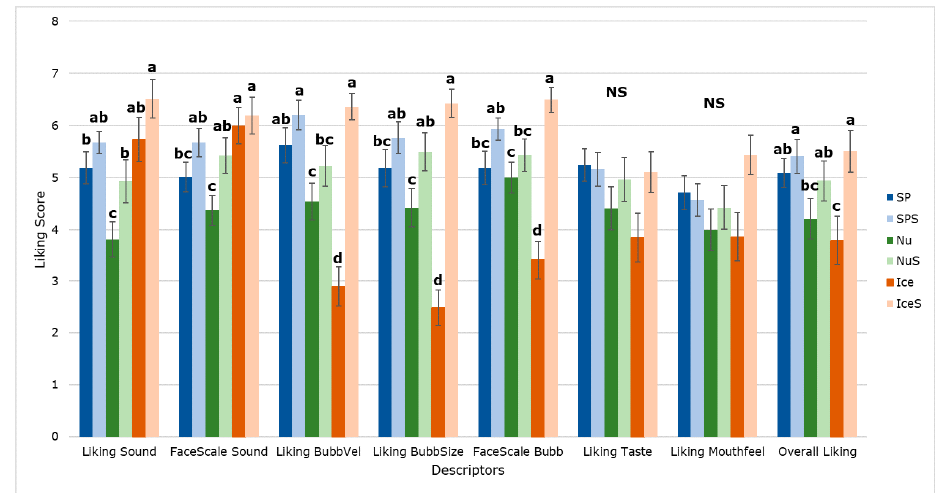
Figure 5. Means of the results from the self-reported responses of consumer acceptability of different sensory attributes. Error bars represent the standard error, and different letters denote significant differences between samples assessed using the Fishers least significant difference test with α = 0.05. NS = non-significant differences between samples, BubbVel = bubble velocity, BubbSize = bubble size, Bubb = bubbles. Table 1 describes the abbreviations of each sample.